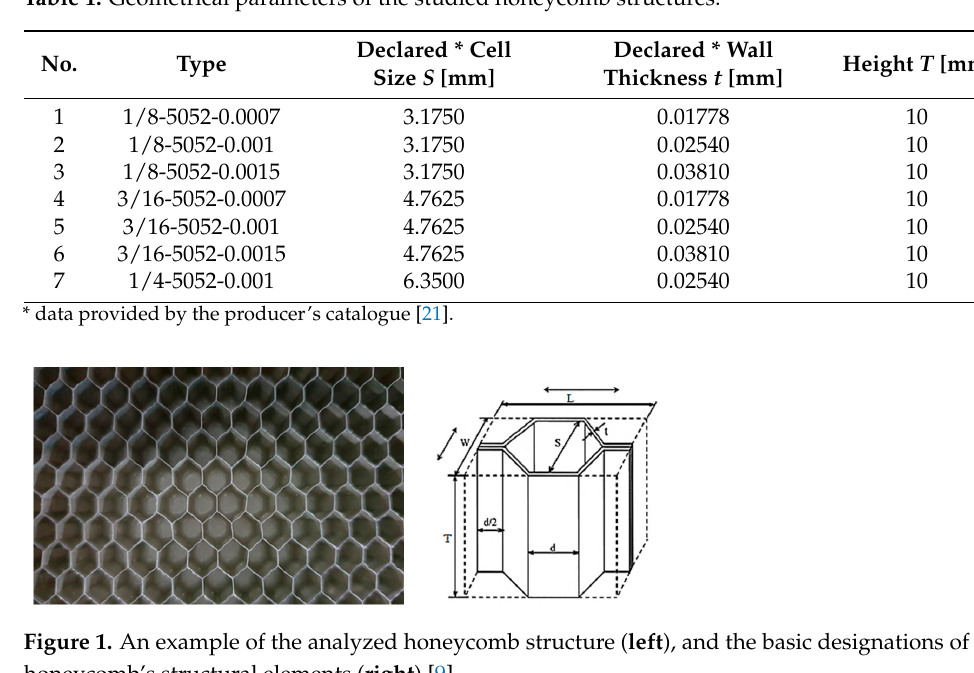
Table 1. Geometrical parameters of the studied honeycomb structures.